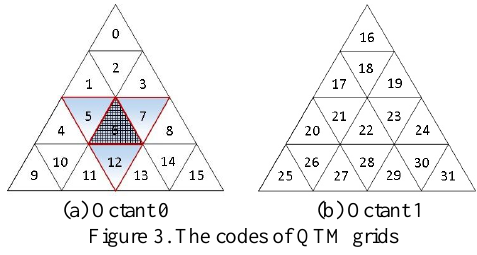
Figure 3. The codes of QTM grids